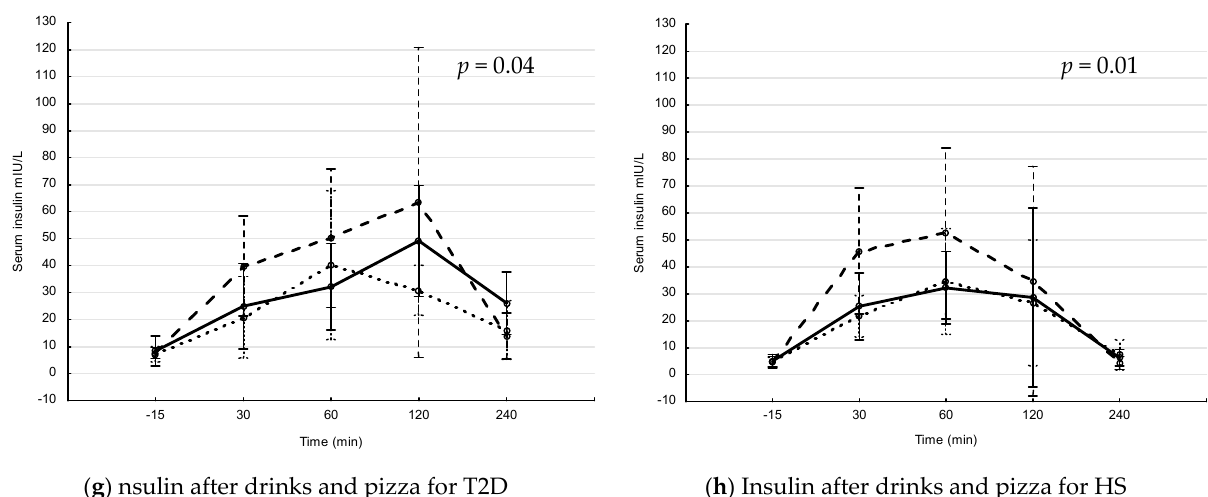
Figure 1. Postprandial glucose and insulin levels in patients with type 2 diabetes (T2D) and healthy subjects (HS) after drinks and drinks + pizza. Mean values with 95% confidence interval. The S-glucose ( a – d ) and S-insulin ( e – h ) levels in patients with T2D and HS. Solid line = blueberry drink, dashed line = Coca-Cola, dotted line = fructose drink. p -values for changes in interventions over time (Repeated measure ANOVA). ( a ) postprandial s-glucose levels after drink interventions in T2D, ( b ) postprandial s-glucose levels after drink interventions in HS, ( c ) postprandial glucose levels after drink + pizza interventions in T2D, ( d ) postprandial s-glucose levels after drink + pizza interventions in HS, ( e ) postprandial s-insulin levels after drink interventions in T2D, ( f ) postprandial s-insulin levels after drink interventions in HS, ( g ) postprandial s-insulin levels after drink + pizza interventions in T2D and ( h ) postprandial s-insulin levels after drink + pizza interventions in HS.